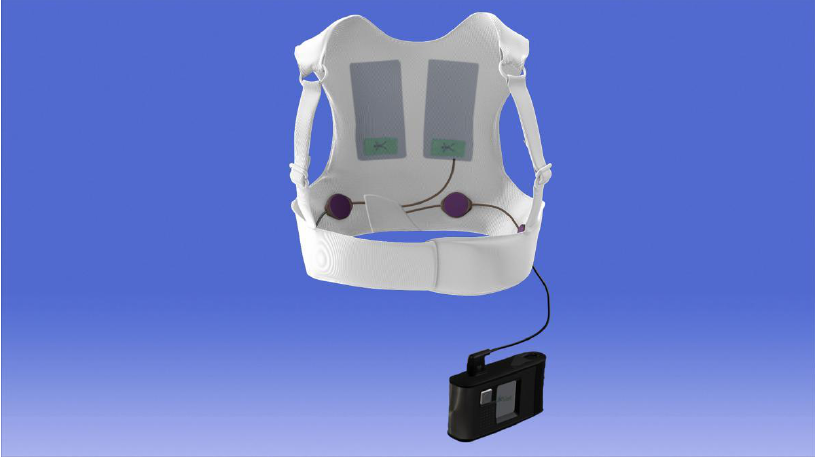
Figure 1. Wearable cardioverter defibrillator, picture courtesy of Zolll Services LLC, Pittsbugh, PA, Figure USA.